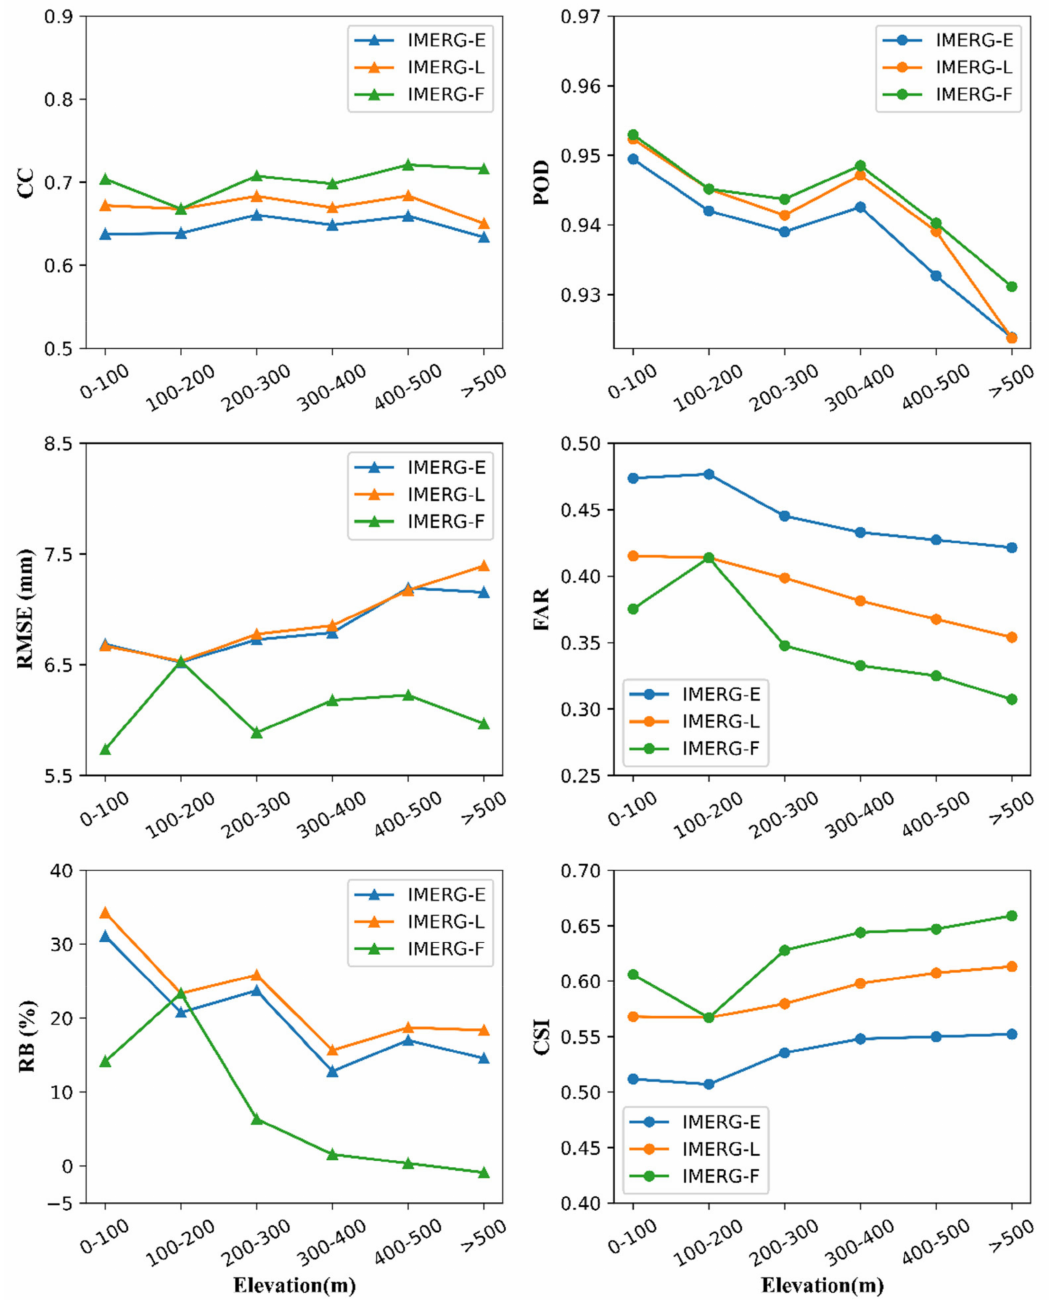
Figure 8. Continuous and categorical verification statistics for IMERG products at the daily scale at different